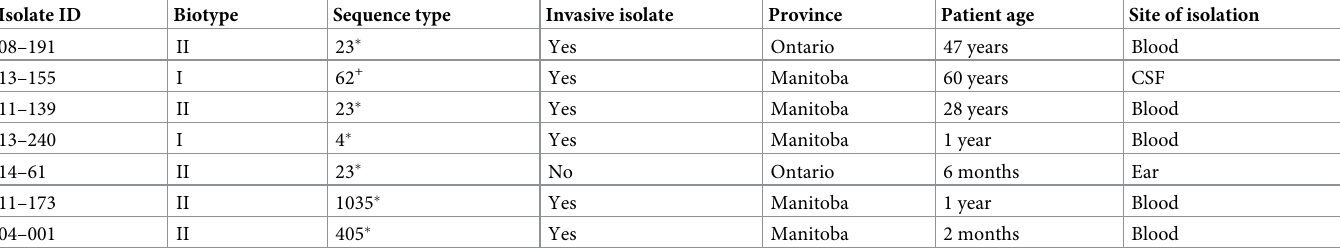
Table 2. Characteristics of Haemophilus influenzae type a clinical